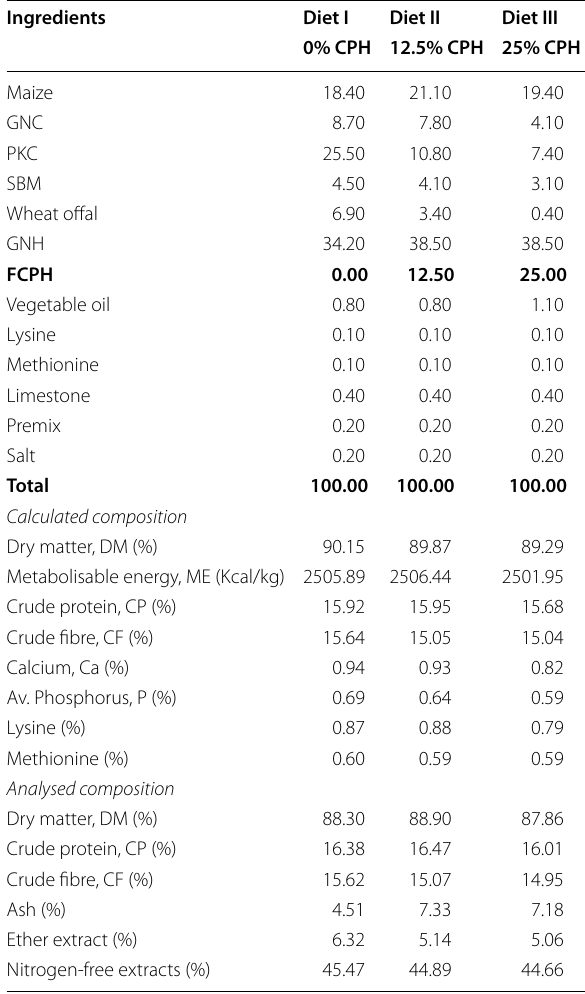
Table 1 Chemical composition of the experimental diets